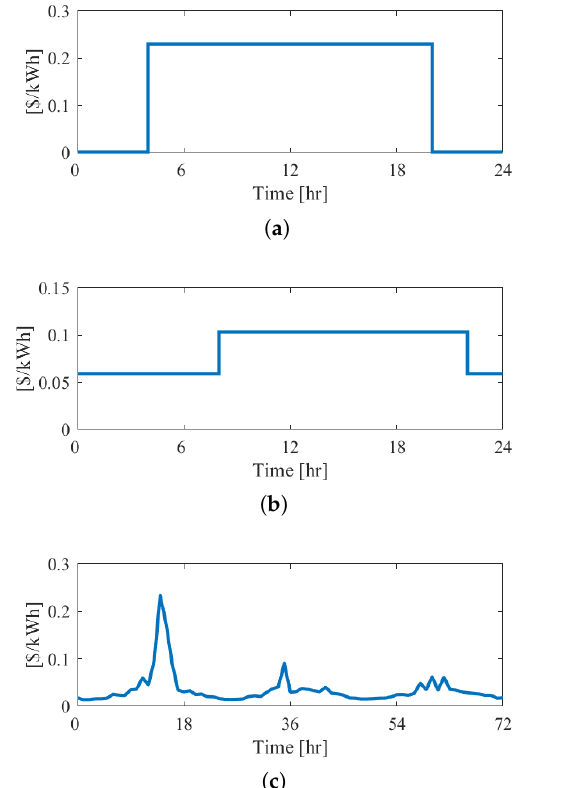
Figure 1. Time-varying electricity pricing schemes. ( a ) TOU scheme with price gap of 23.5 ¢/kWh: state of Texas. ( b ) TOU scheme with price gap of 4.9 ¢/kWh: South Korea. ( c ) RTP scheme: city of Chicago.